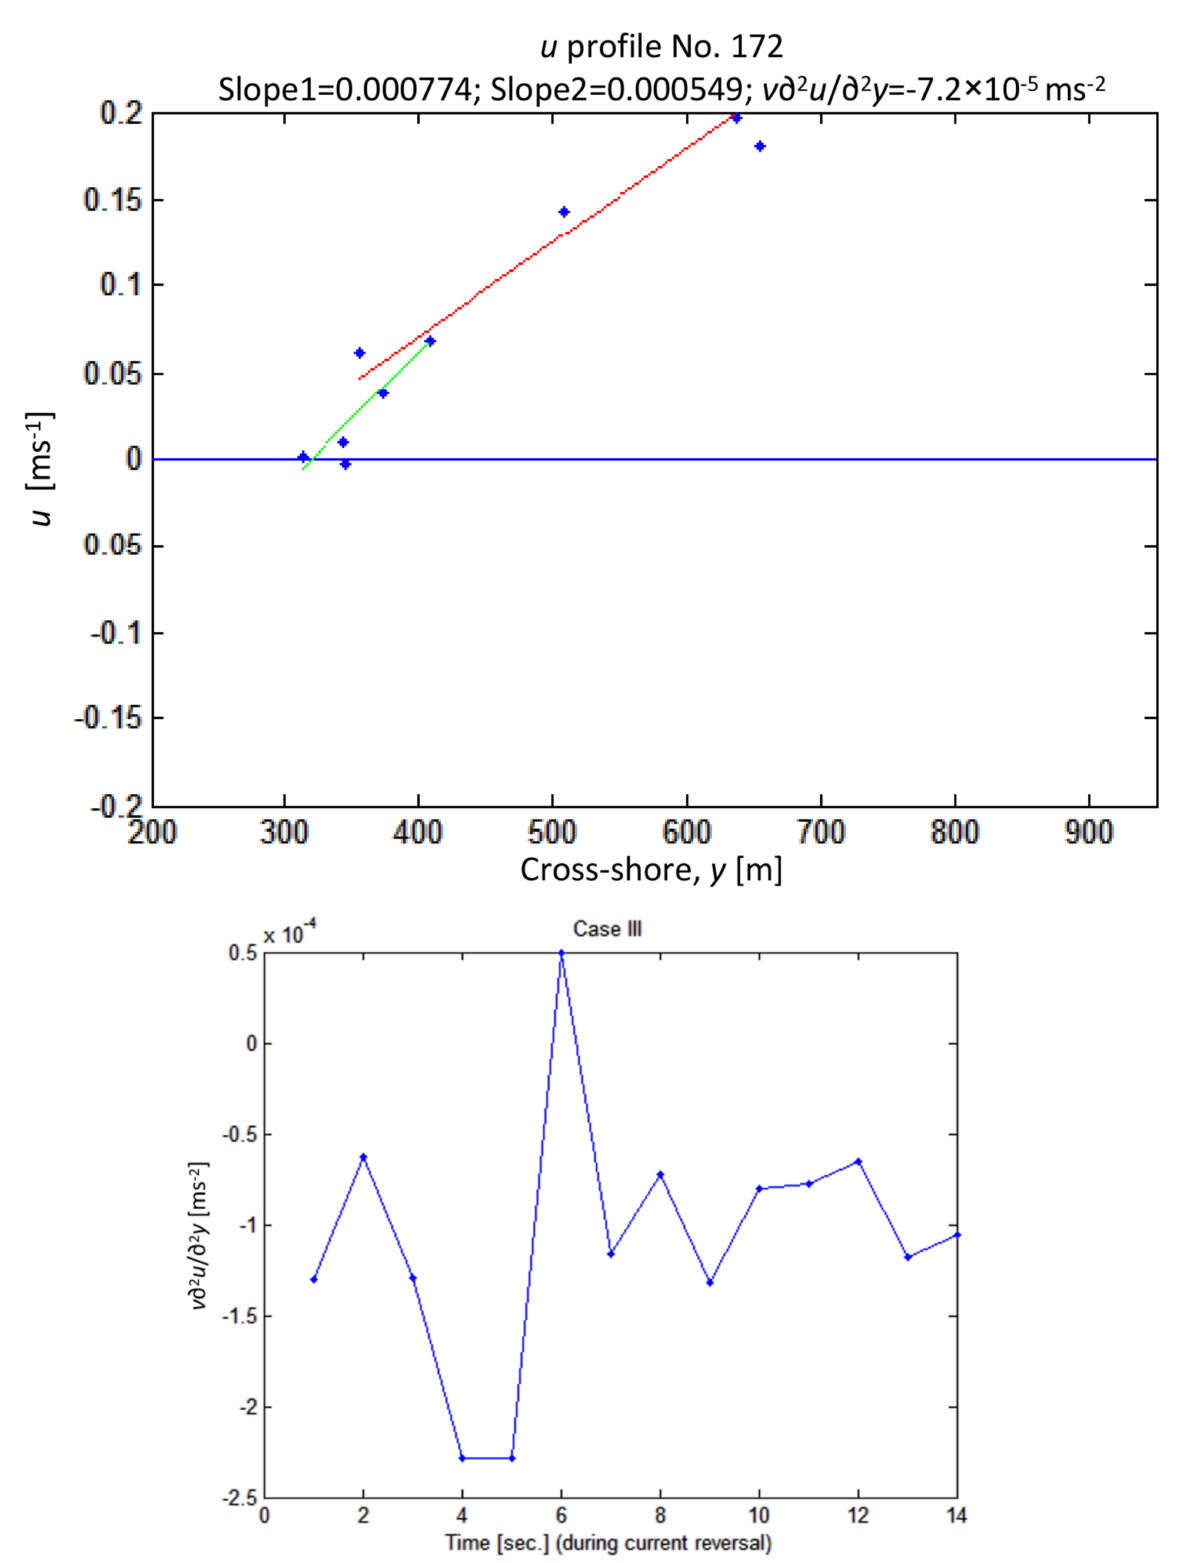
Figure A4. Calculation example of the horizontal dispersion term based on the drifter data of Case III (upper panel). Time series of the horizontal dispersion term of Case III (lower panel). Secondly, the mean offshore distances of the points were calculated in the near-shore area and the off-shore